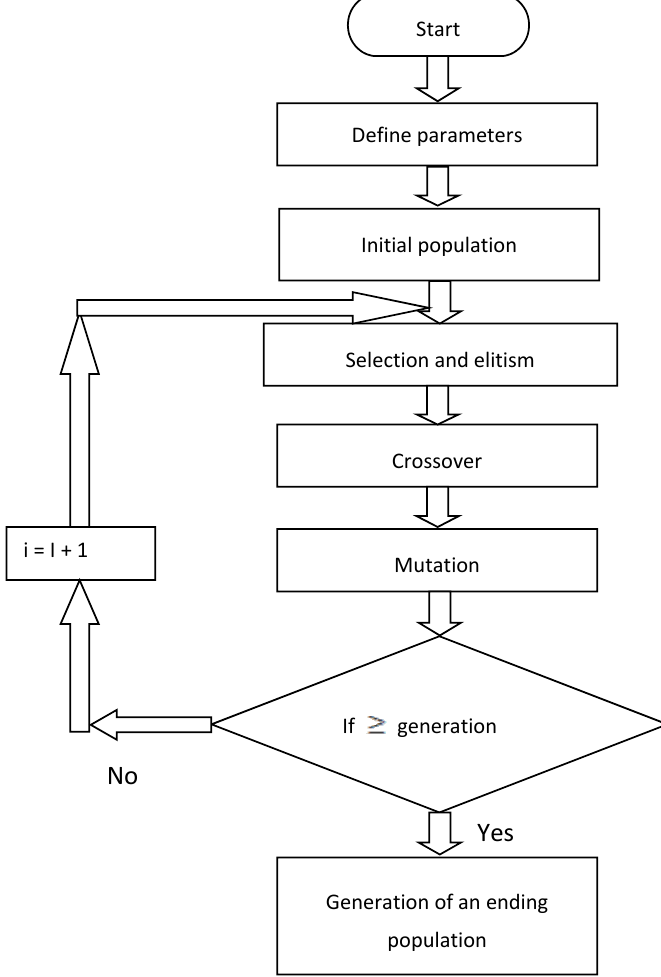
Figure 3. Flowchart of the genetic algorithm .